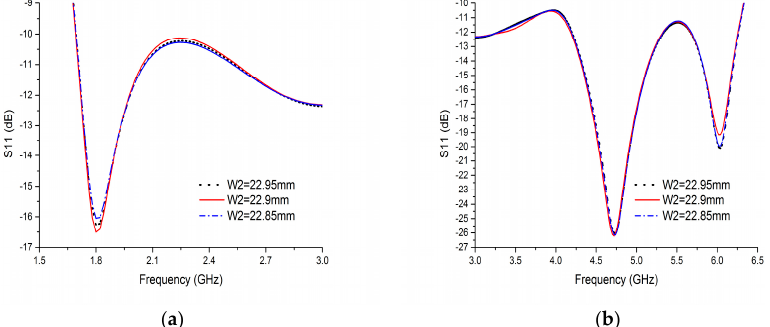
Figure 9. Reflection coefficient (S11) of the BRA versus frequency with the variation of W2: ( a ) 1.5 GHz–3 GHz; ( b ) 3 GHz–6.5 GHz.